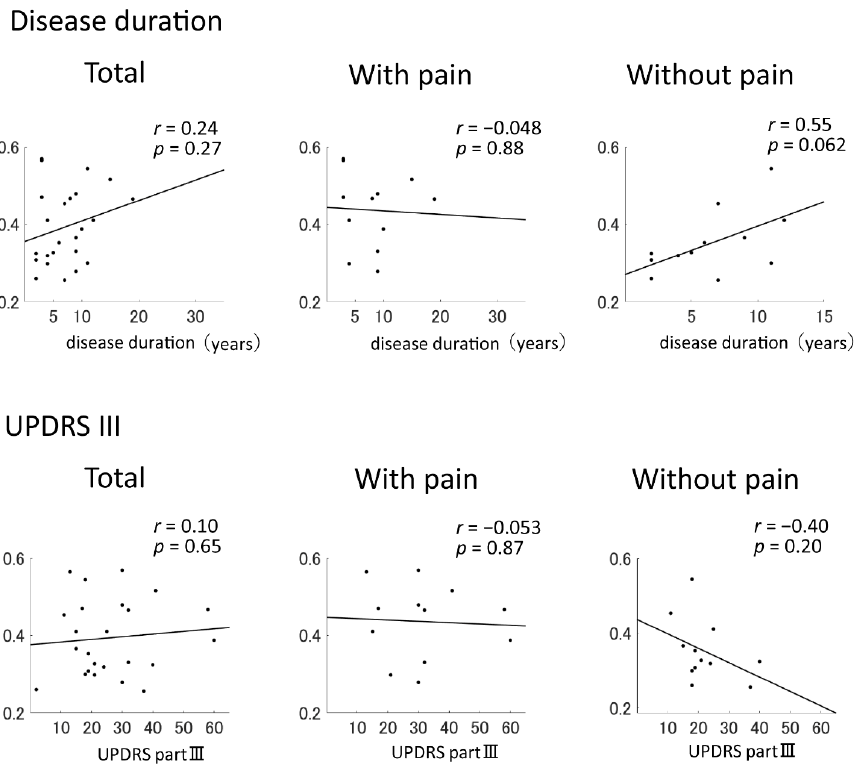
Figure 1. Pearson correlation coefficients and graphs for the correlation of temporal–temporal coherence in the alpha range with disease duration and MDS-UPDRS-III score. The lines indicate the approximate line using the least squares method. MDS-UPDRS-III = Movement Disorder Society Unified Parkinson’s Disease Rating Scale Part III.